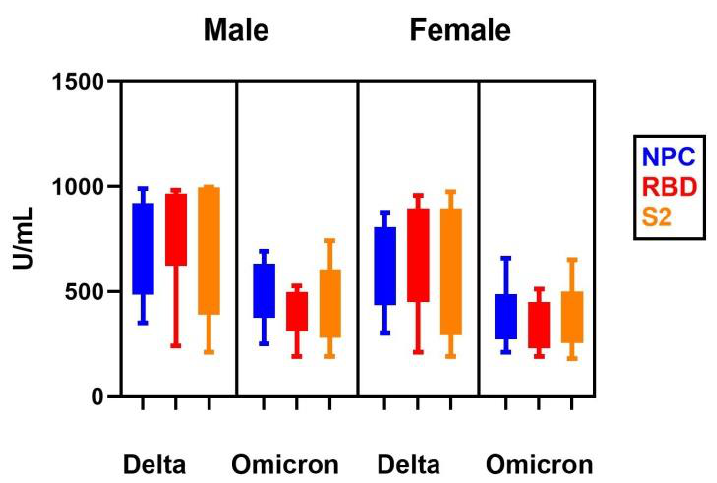
Figure 2. The serum level of NCP, RBD, and S2 antibody in patients after SARS CoV-2 Delta variant and Omicron variant infection by sex.